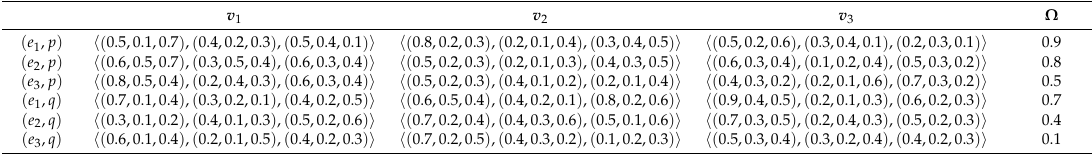
Table 3. Disagree-neutrosophic soft expert multiset.